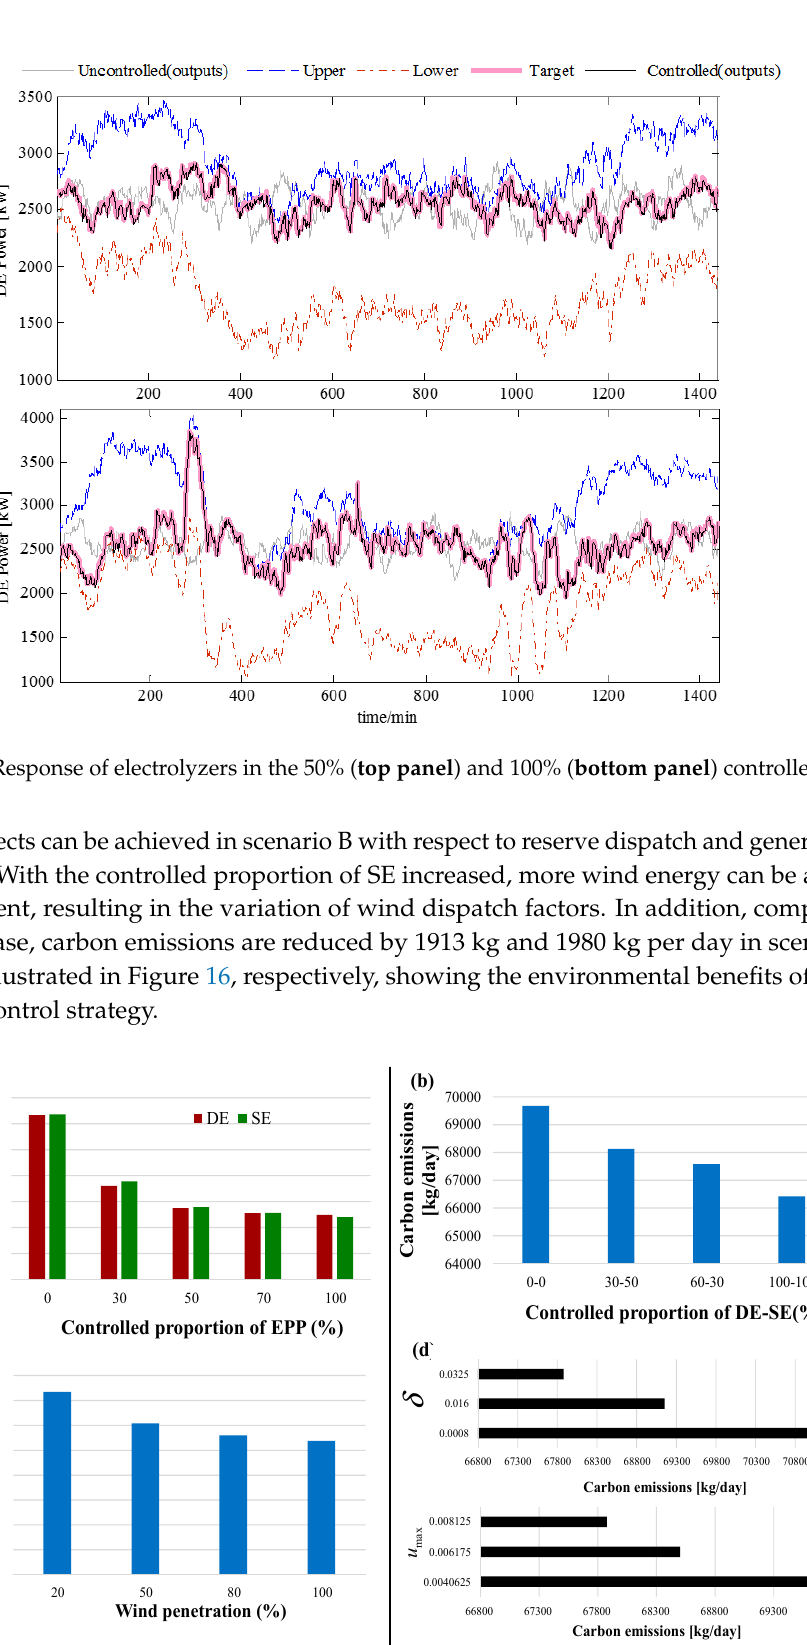
Figure 11. Energy state of a single DE in the uncontrolled ( top panel ) and controlled ( bottom panel ) case.